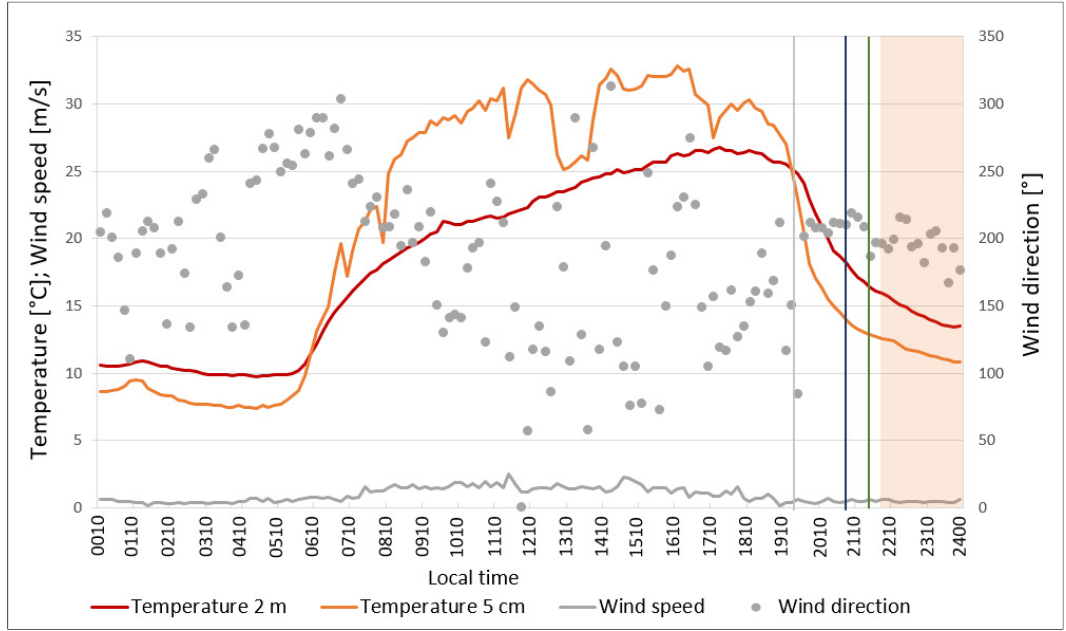
Figure 3. Temperature and wind conditions at the weather station on 23 July 2012, 00:10–24:00 local time (LT). Grey line: moment of inversion at the weather station; blue line: shadowing of the operation area at 20:50 LT; green line: sunset in Bochum at 21:33 LT; orange box: TIR measurement period (started at 20:50 LT, technical problems allowed continuous data from 21:50 LT on).